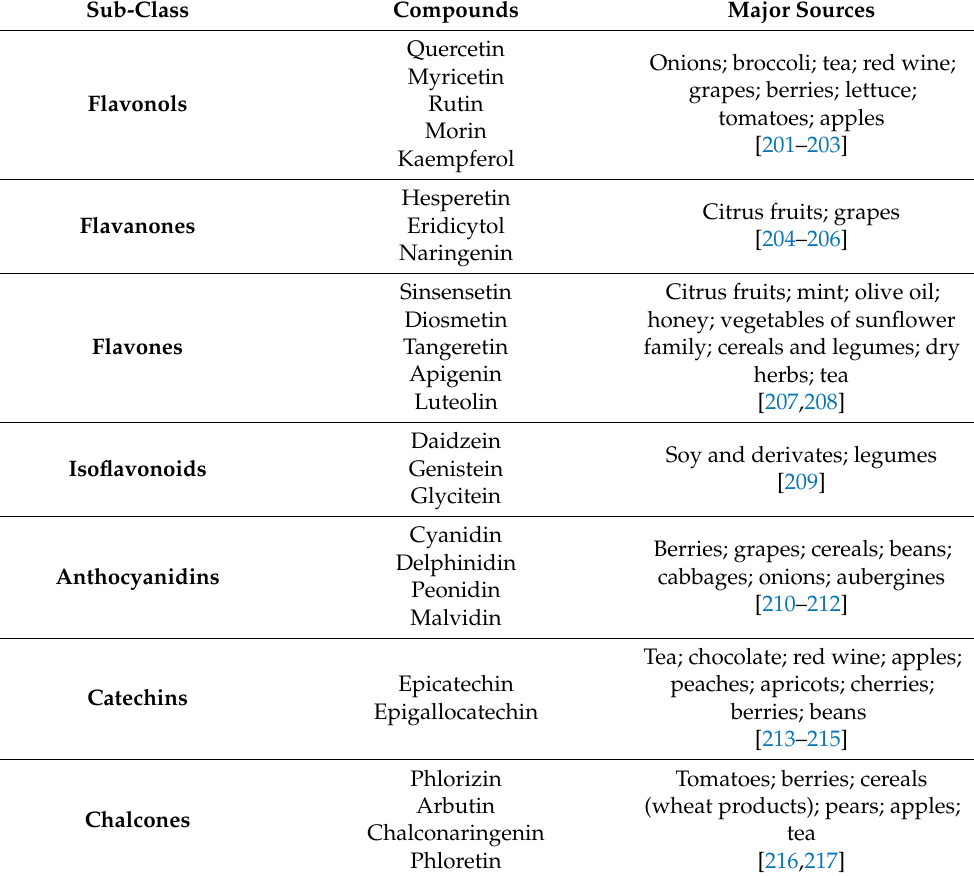
Table 1. Sub-classes of flavonoid phenolic compounds, examples of compounds for each different sub-class, and their main dietary